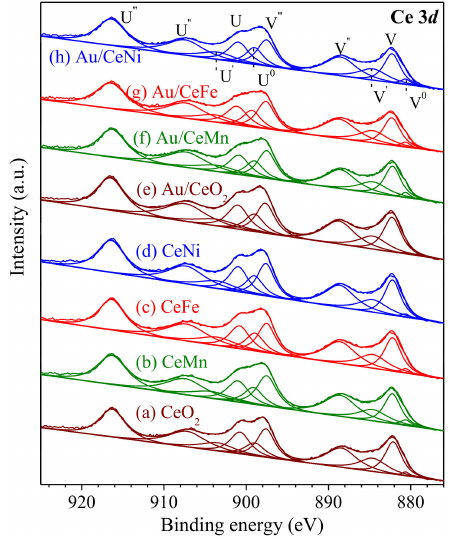
Figure 6. Ce 3 d XPS spectra of CeO 2 , CeM mixed oxides with different dopants and corresponding supported Au/CeM catalysts: ( a ) CeO 2 ; ( b ) CeMn; ( c ) CeFe; ( d ) CeNi; ( e ) Au/CeO 2 ; ( f ) Au/CeMn; ( g ) Au/CeFe; ( h )